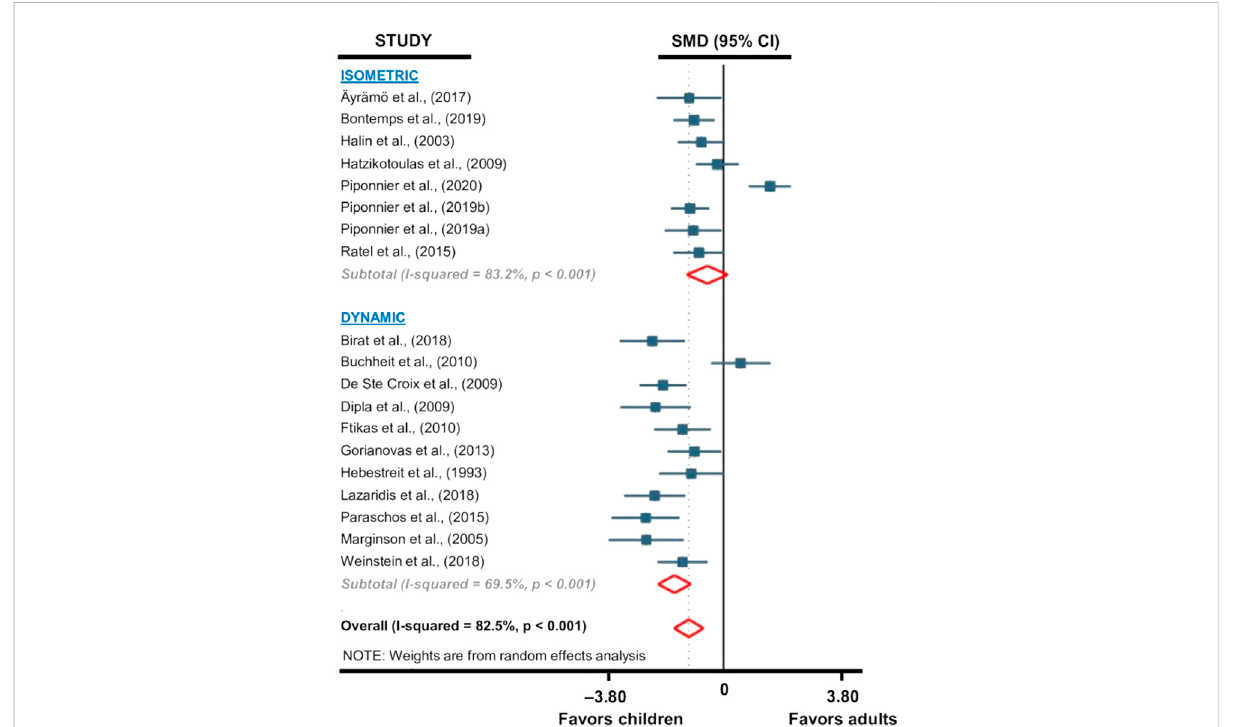
FIGURE 5 Forest plot from the subgroup meta-analysis reporting the in fl uence of exercise modality (i.e., isometric or dynamic) on fatigability differences between children and adults. Raw SMDs (with 95% con fi dence intervals) and % weights of the meta-analyzed studies are given in Figure